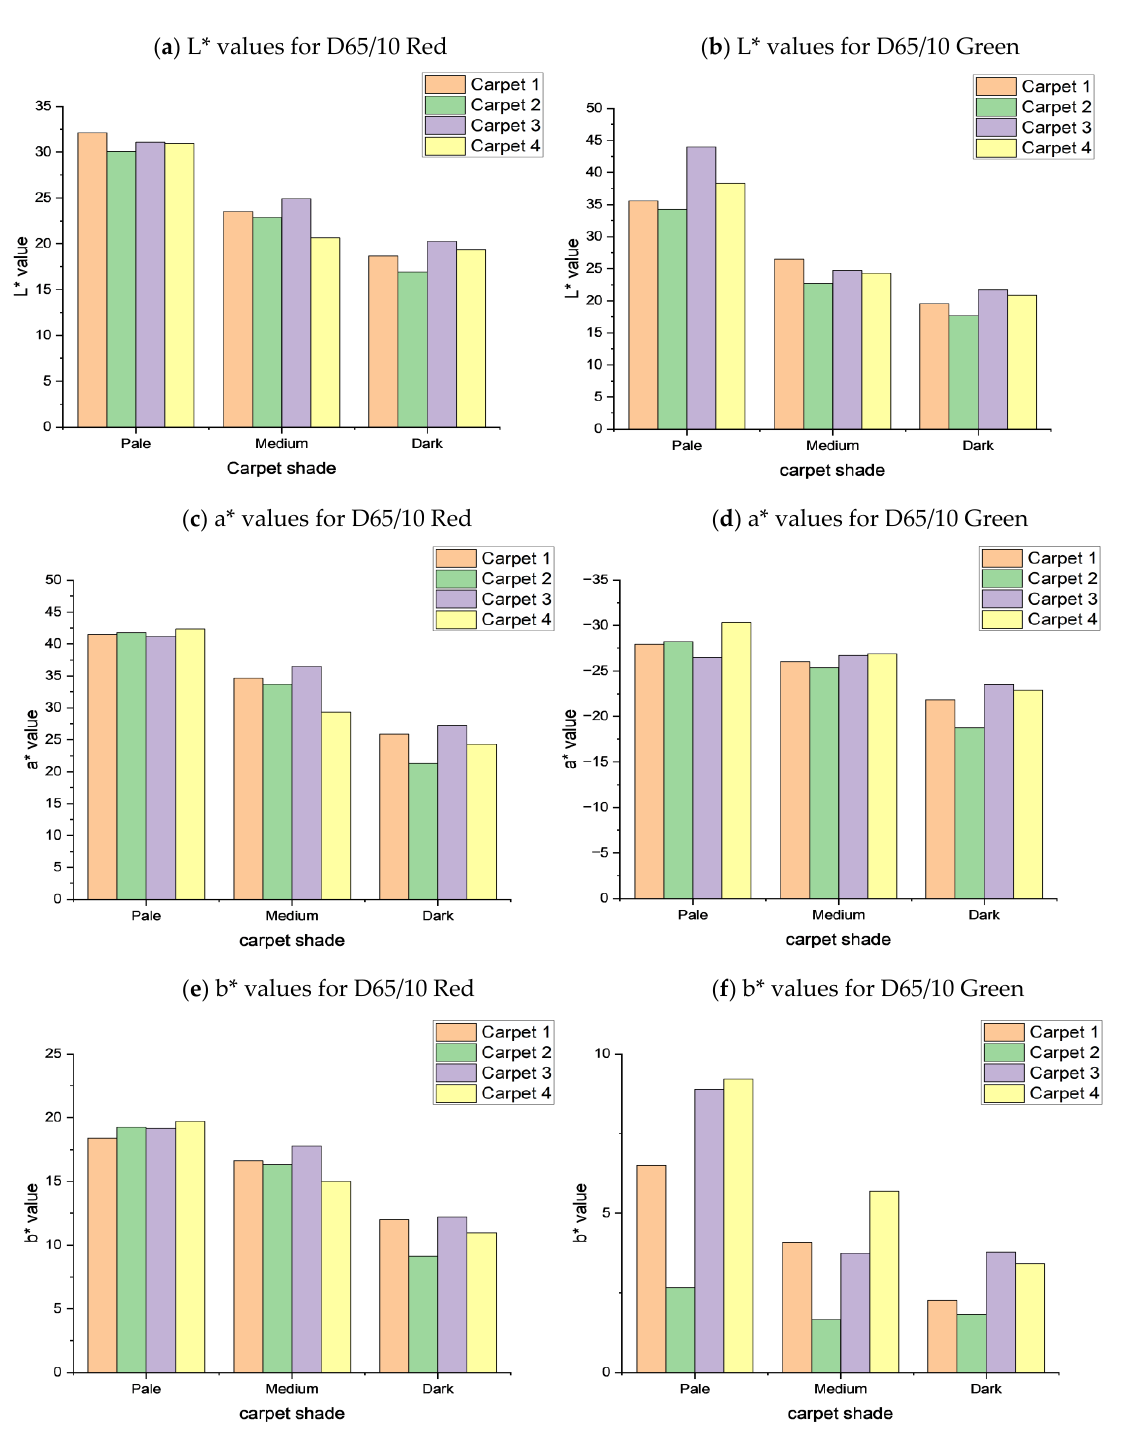
Figure 3. CIE L*, a*, and b* values for D65/10 illumination of different carpets dyed in different shades of red and green color ( a ) L* values for red-colored carpets ( b ) L* values for green-colored carpets ( c ) a* values for red-colored carpets ( d ) a* values for green-colored carpets ( e ) b* values for red-colored carpets ( f ) b* values for green-colored carpets.